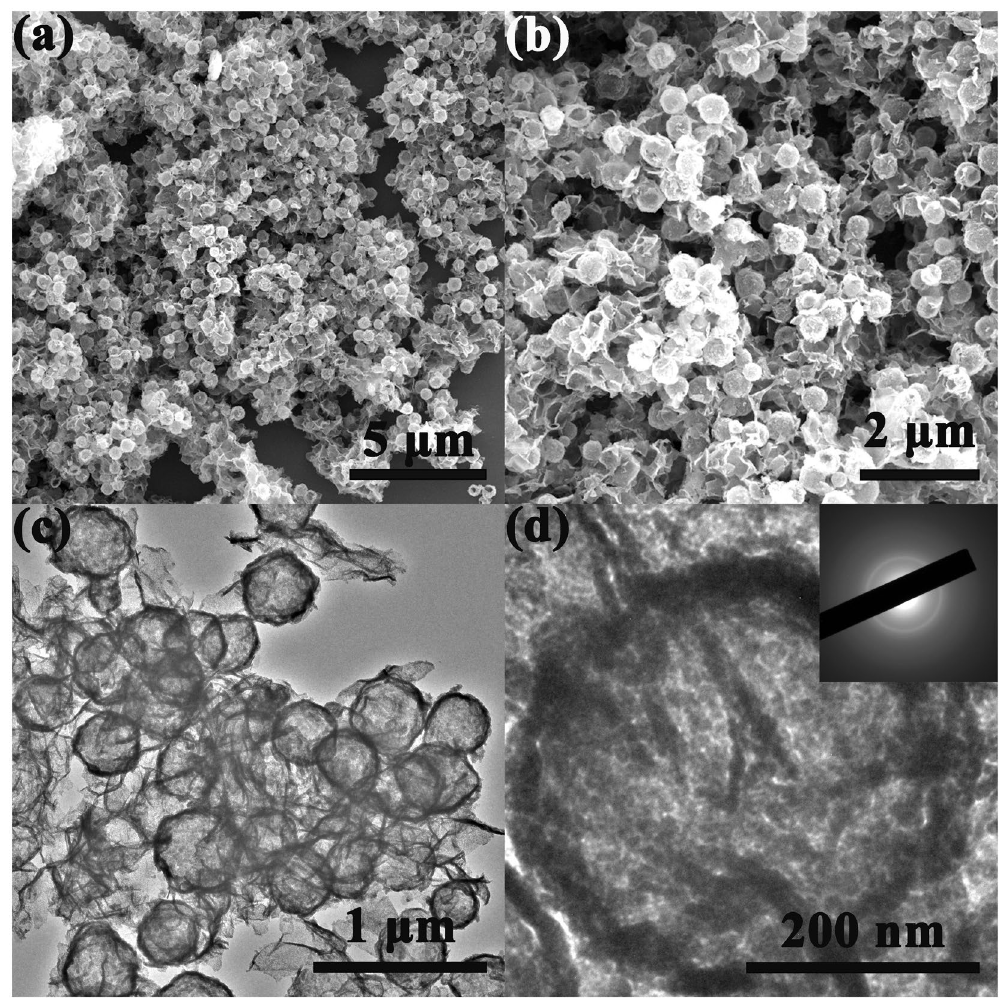
Figure 3. SEM ( a , b ) and TEM ( c , d ) images of the 3D Ni(OH) 2 hollow sphere/GO composite. The inset in ( d ) is the corresponding SAED